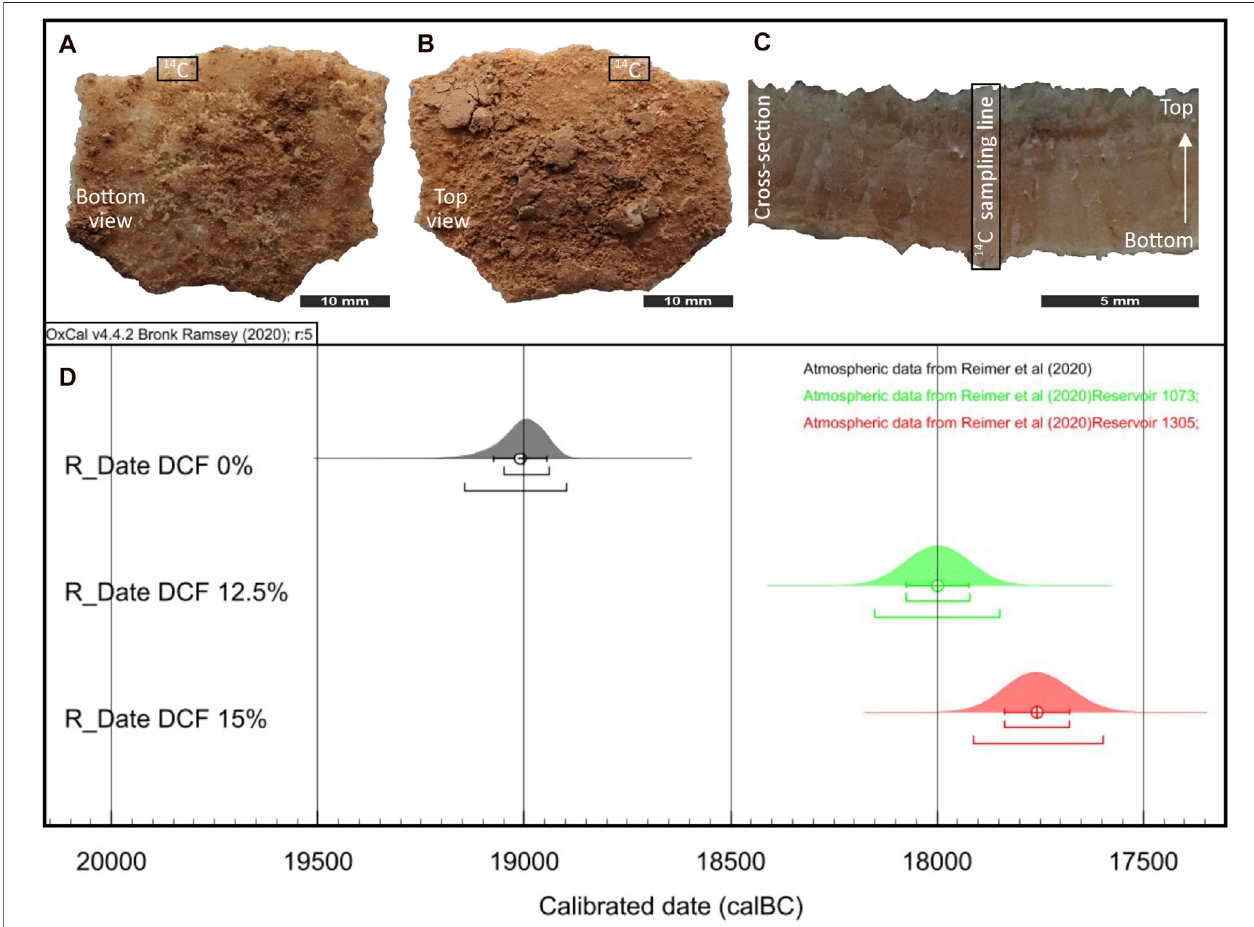
FIGURE9| Sampled fl owstone( 14 C)fromtheDC-SPpro fi leintheLowerCerova ˇ ckaCave (A) Bottomview, (B) topview, (C) cross-sectionwithindicatedsampling line, (D) calibration curves for 14 C date without DCF correction (in gray), and for 12.5% ( “ Reservoir 1,073, ” in green) and 15% ( “ Reservoir 1,305, ” in red) DCF.